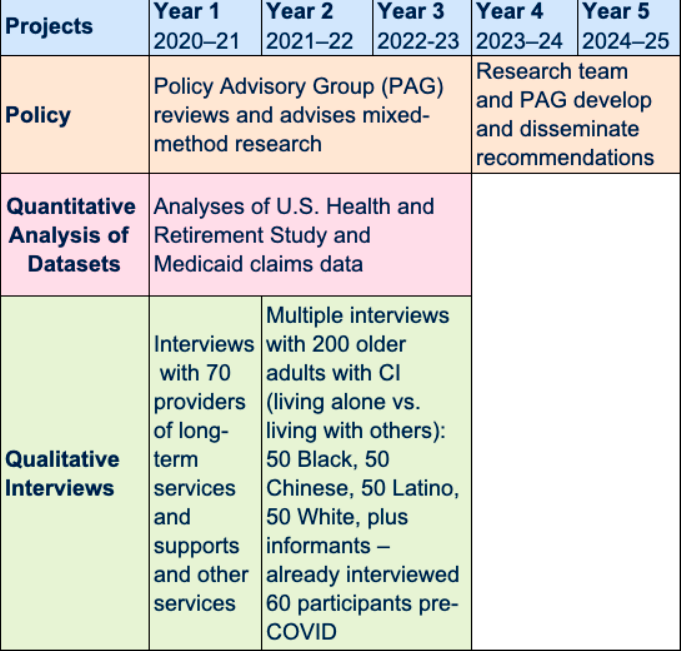
Figure 1. Timeline and activities of the Living Alone with Cognitive Impairment Project.